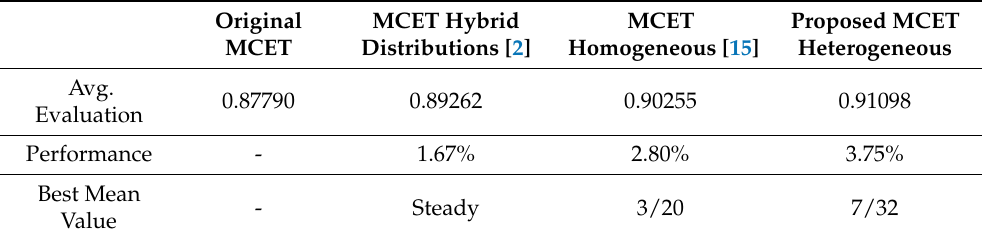
Table 4. Overall comparison between the proposed MCET based on heterogeneous mean filter approaches and the related